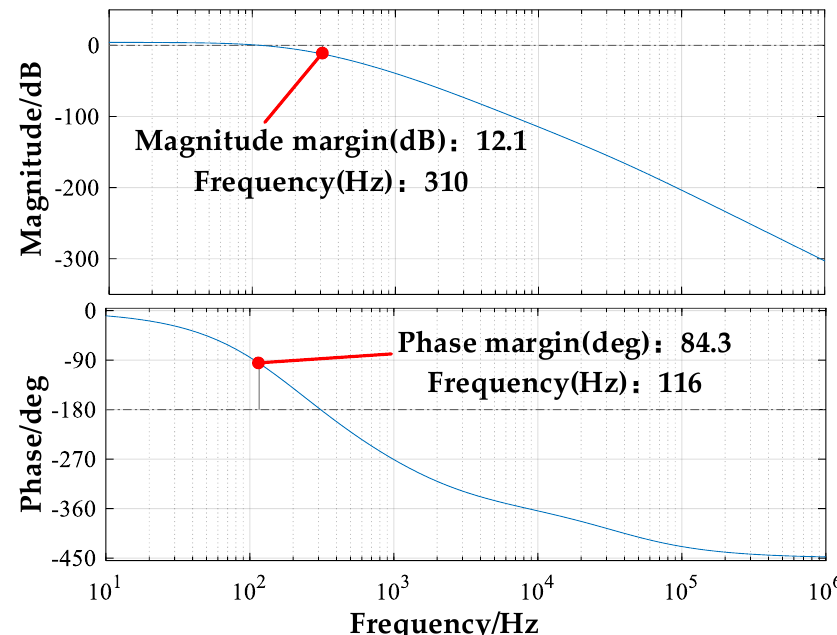
Figure 26. Bode diagram of the pre-stage.